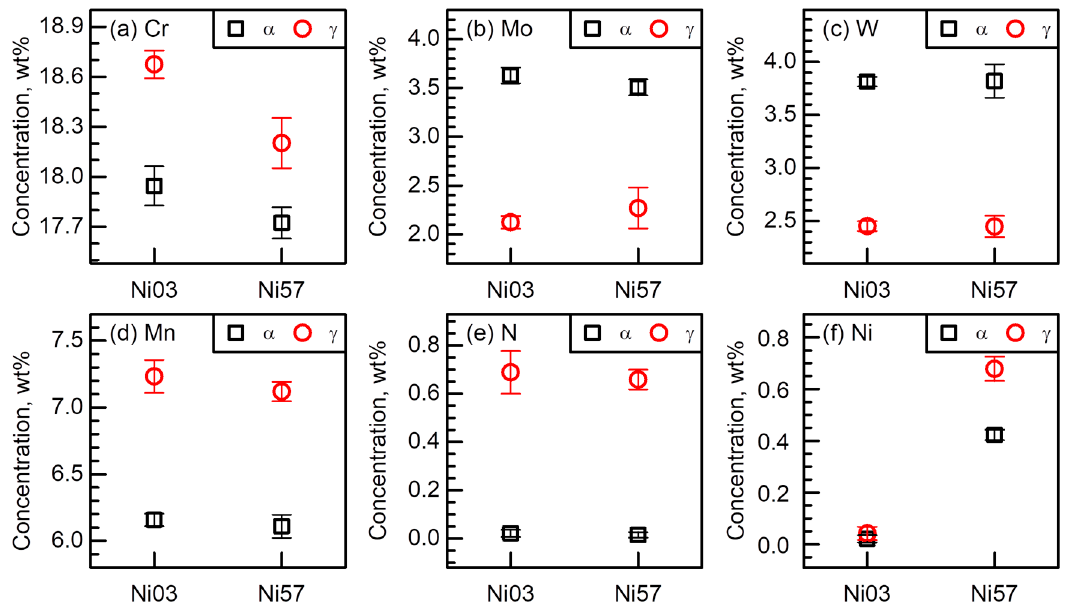
Figure 4. Chemical compositions of ( a ) Cr ( b ) Mo, ( c ) W, ( d ) Mn, ( e ) N, and ( f ) Ni of the α and γ phases in the Ni03 and Ni57 alloys measured using the EPMA.